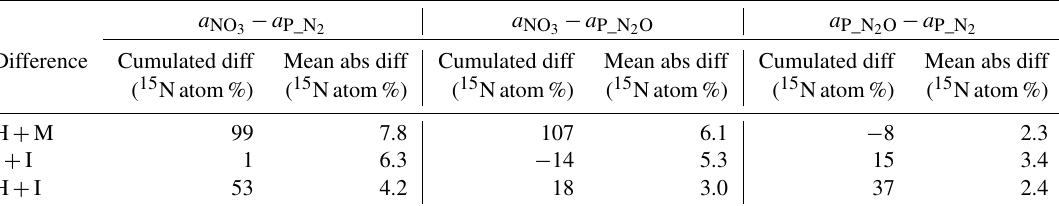
or a P_N or a P_N ). 2 3 2 O